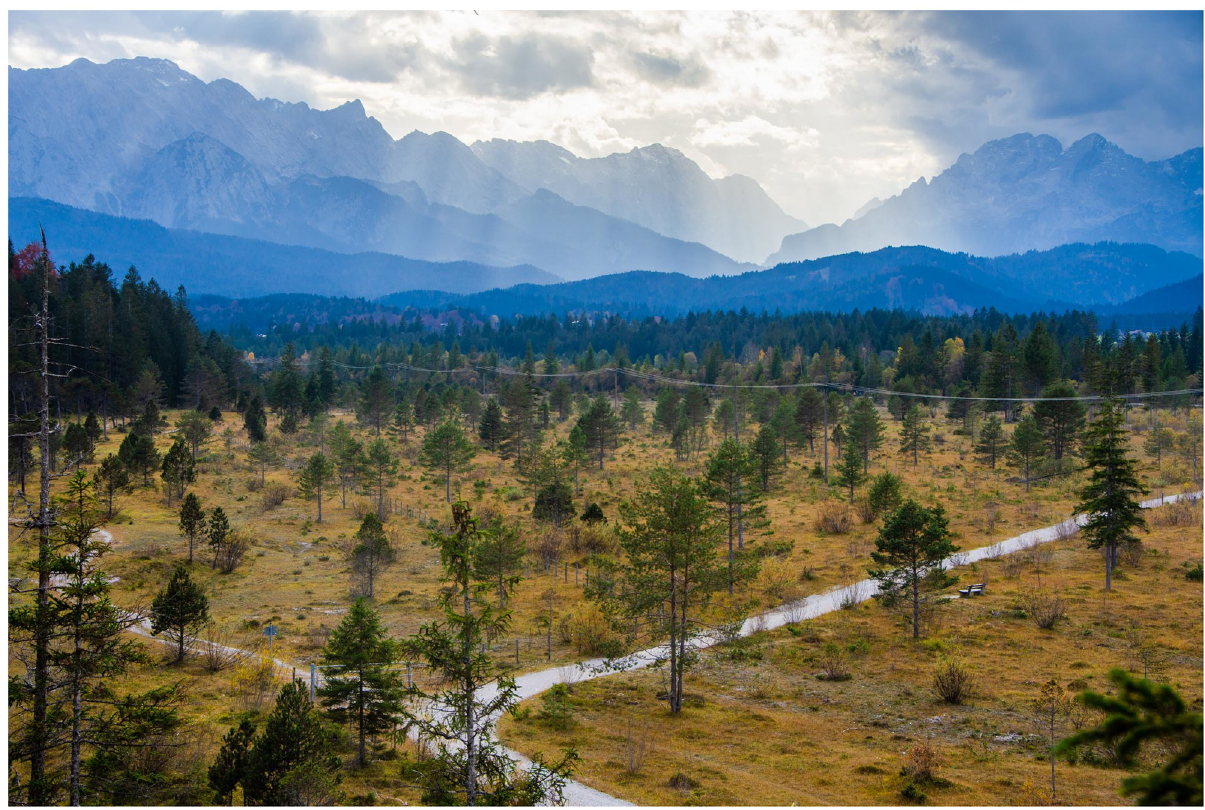
Fig 1. Deciding while acting. Should I take the well-paved road towards the darker clouds or the more strenuous rougher track with lower risk of rain? With enough time for deliberation, one could research track conditions and the weather forecast to achieve optimal choice. But when going downhill at a fast pace, the intersection comes closer quickly and the urge to commit to one of the two paths before having collected all possible evidence grows. Similarly, deciding and acting in a tightly integrated fashion is an important survival skill for primates and most other animals during ecologically relevant behaviors. The unifying framework provided by Thura and colleagues [6] describes the underlying neurophysiological processes as a distributed dynamic system composed of different cortical and subcortical regions of the primate brain, where different regions contribute specific aspects of choice behavior, like the evidence in favor of either option or the urgency to